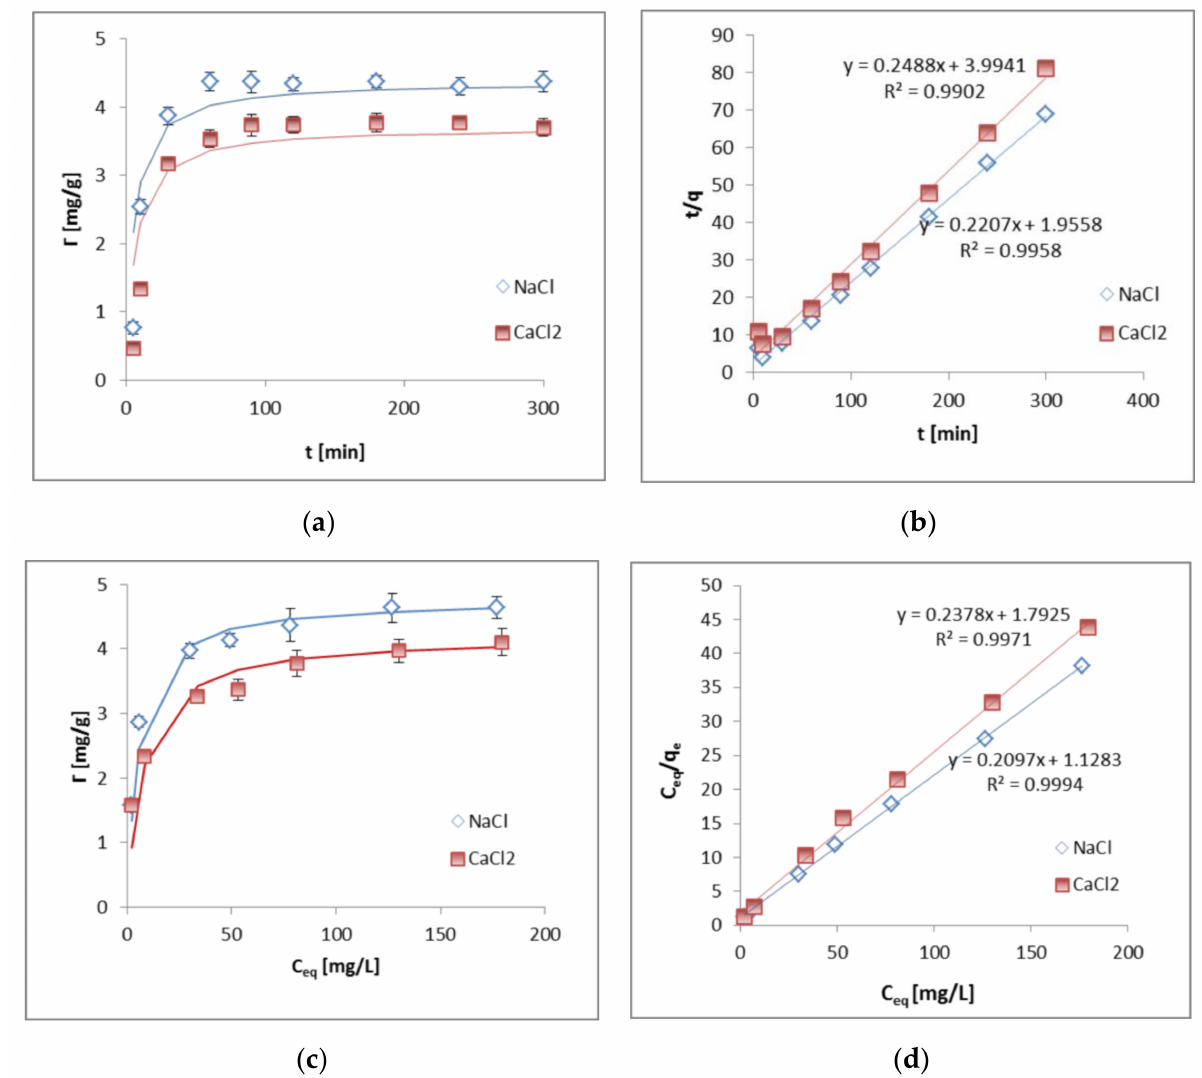
Figure 1. Copper(II) ion adsorption kinetics on kaolinite: data (points) and pseudo second-order fitting (lines) in the NaCl or CaCl 2 solution ( a ) as well as the obtained linear forms of PSO Equation ( b ); Adsorption isotherms of copper(II) ions on kaolinite: data (points) and Langmuir fitting (lines) ( c ) as well as their linear forms ( d ); at pH 5, in the NaCl or CaCl 2